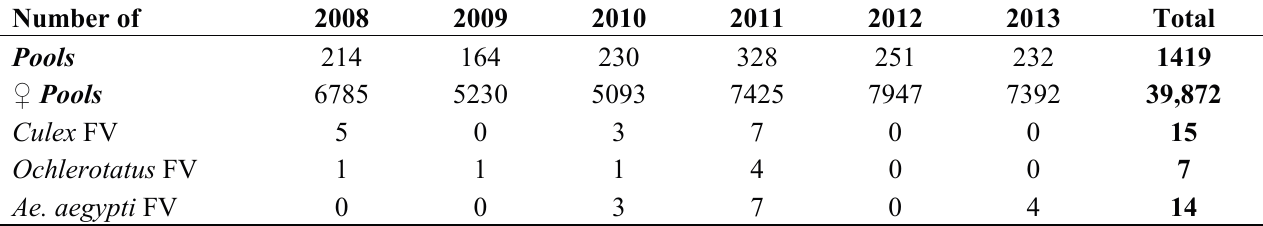
Table 5. Flaviviruses detected in mosquitoes collected in Portugal in the frame of REVIVE. Number